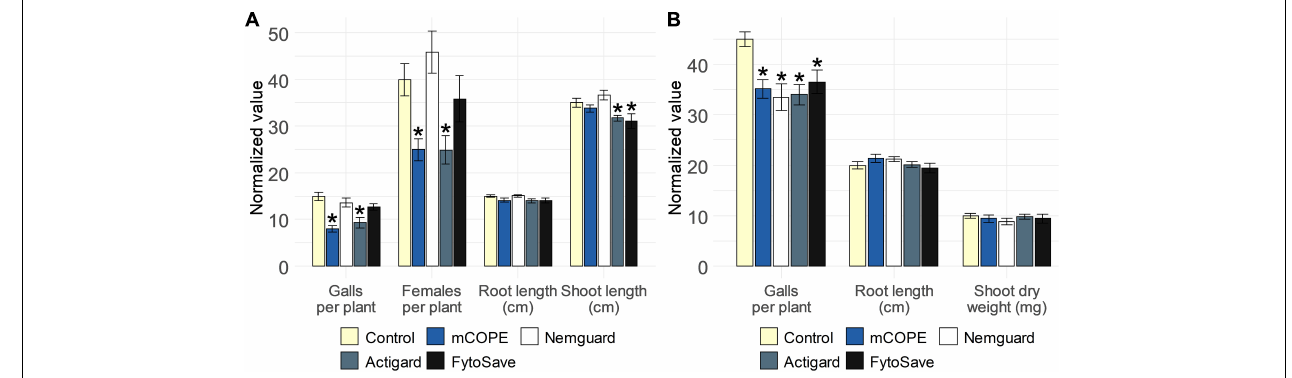
FIGURE 6 | Cucurbitaceae COld Peeling Extract (CCOPE) derived from melon ( Cucumis melo var. cantalupensis ; mCOPE) leads to similar or better protection for the pathosystems (A) rice- Meloidogyne graminicola ( Mg ) and (B) tomato- Meloidogyne incognita ( Mi ) when compared to commercially available nematicides or IR stimuli. (A) Normalized infection and growth parameters, as assessed for rice plants 14 days post inoculation with 250 Mg second-stage juveniles (J2s). (B) Normalized infection and growth parameters, as assessed for tomato plants 28 days post inoculation with 250 Mi J2s. (A,B) One day before inoculation, shoots of 14-days-old plants were treated with the buffer used for CCOPE preparation, mCOPE, Actigard R (cid:13) [250 µ M benzothiadiazole (BTH)] or FytoSave R (cid:13) [0.5% (v/v), corresponding with a chito-oligosaccharides and oligogalacturonides (COS-OGA) concentration of 12.5 g/L]. A solution of 0.133 g/L Nemguard R (cid:13) was administered via soil drenching 1 day before nematode inoculation according to the manufacturer’s instructions. Error bars represent the standard error of the mean. Asterisks indicate significant differences upon comparison of all treatments with same-aged, mock-treated control plants. Statistical differences were determined via a two-sided heteroscedastic t -test ( p < 0.05). Asterisks indicate statistically significant differences upon comparison of CCOPE- and mock-treated cells.